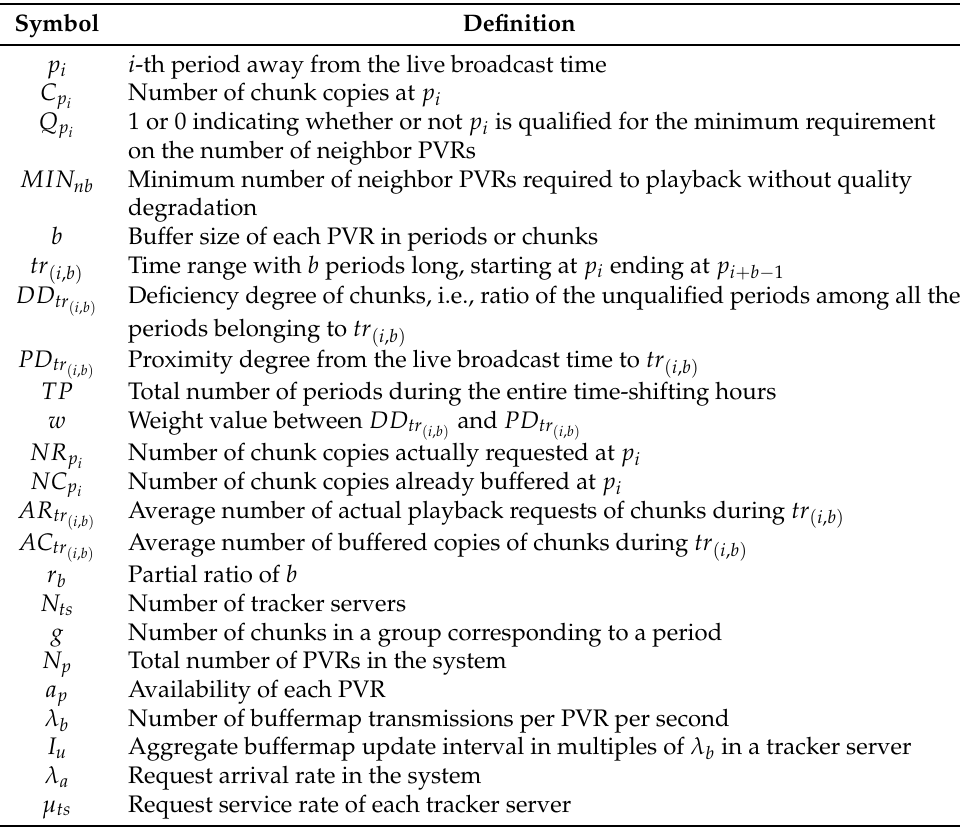
Table 1. Summary of